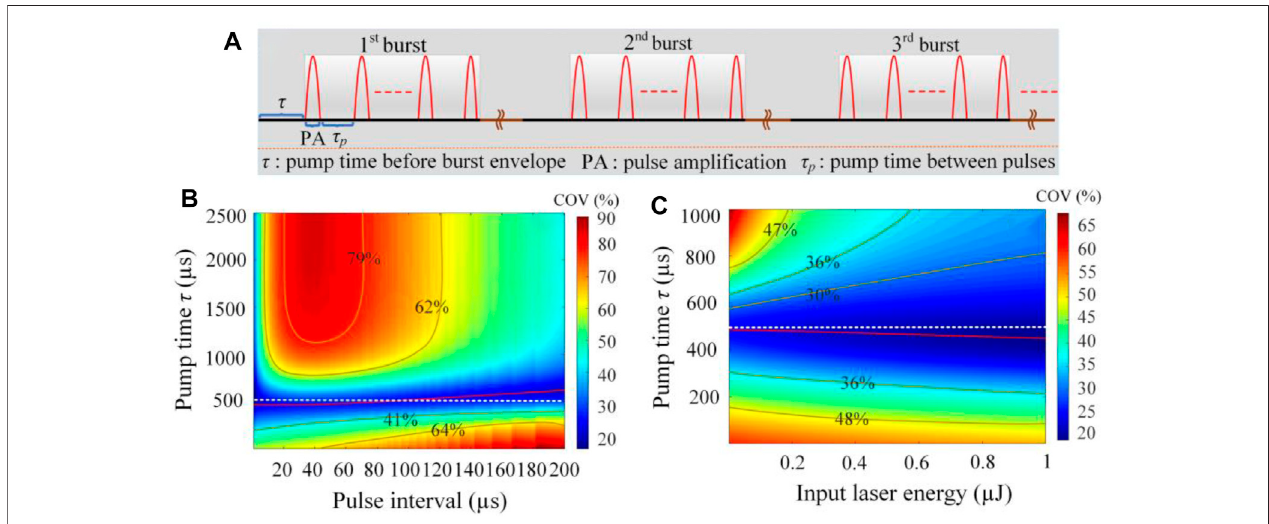
FIGURE1|(A) Schematicofthepumpandampli fi cationcycleforthepulseburstlaser; (B) COVversuspumptime τ andpulseinterval; (C) COVversuspumptime τ and input seed energy.